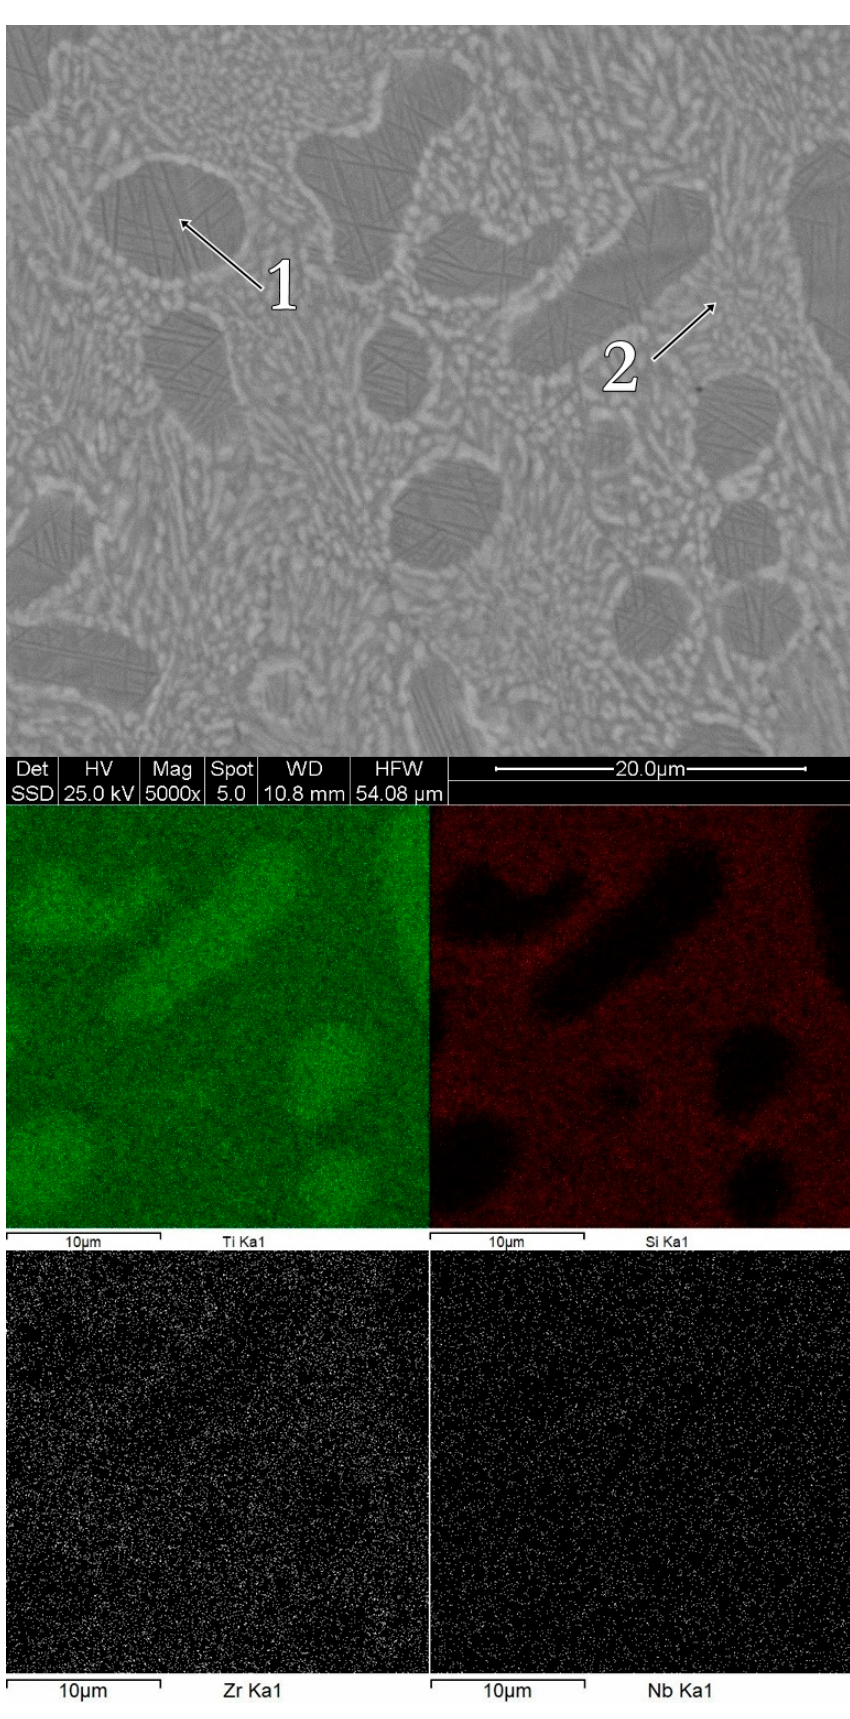
Figure 5. Surface morphology and chemical mapping for the bulk Ti 60 Zr 10 Si 15 Nb 15 alloy.